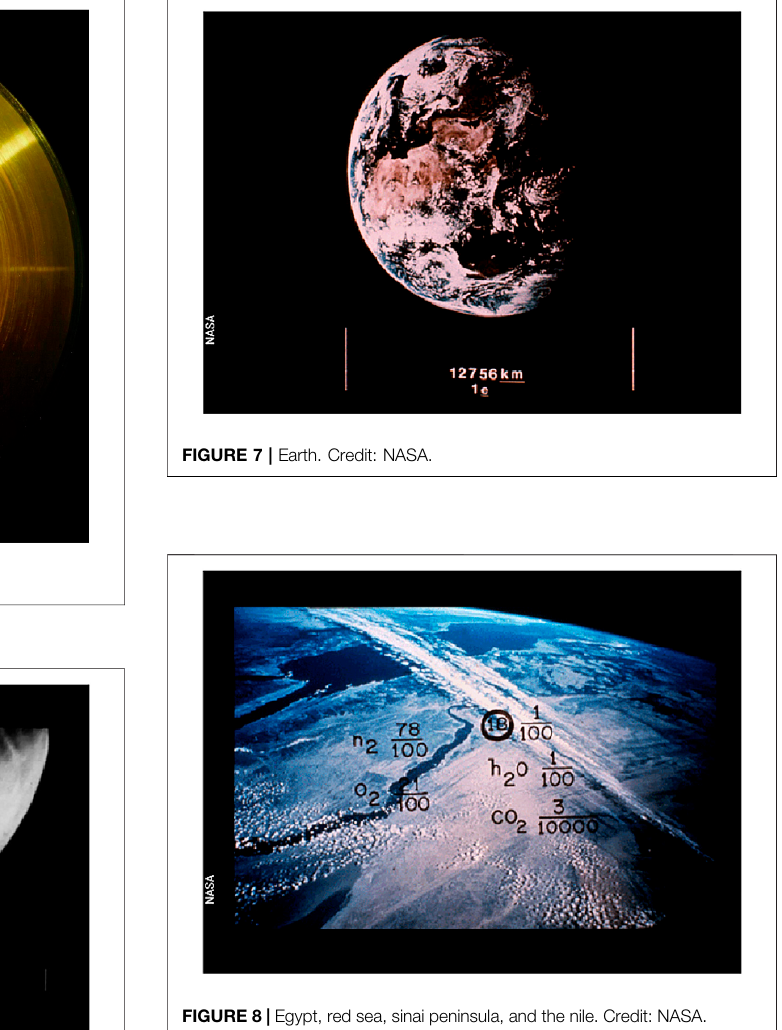
FIGURE 8 | Egypt, red sea, sinai peninsula, and the nile. Credit: